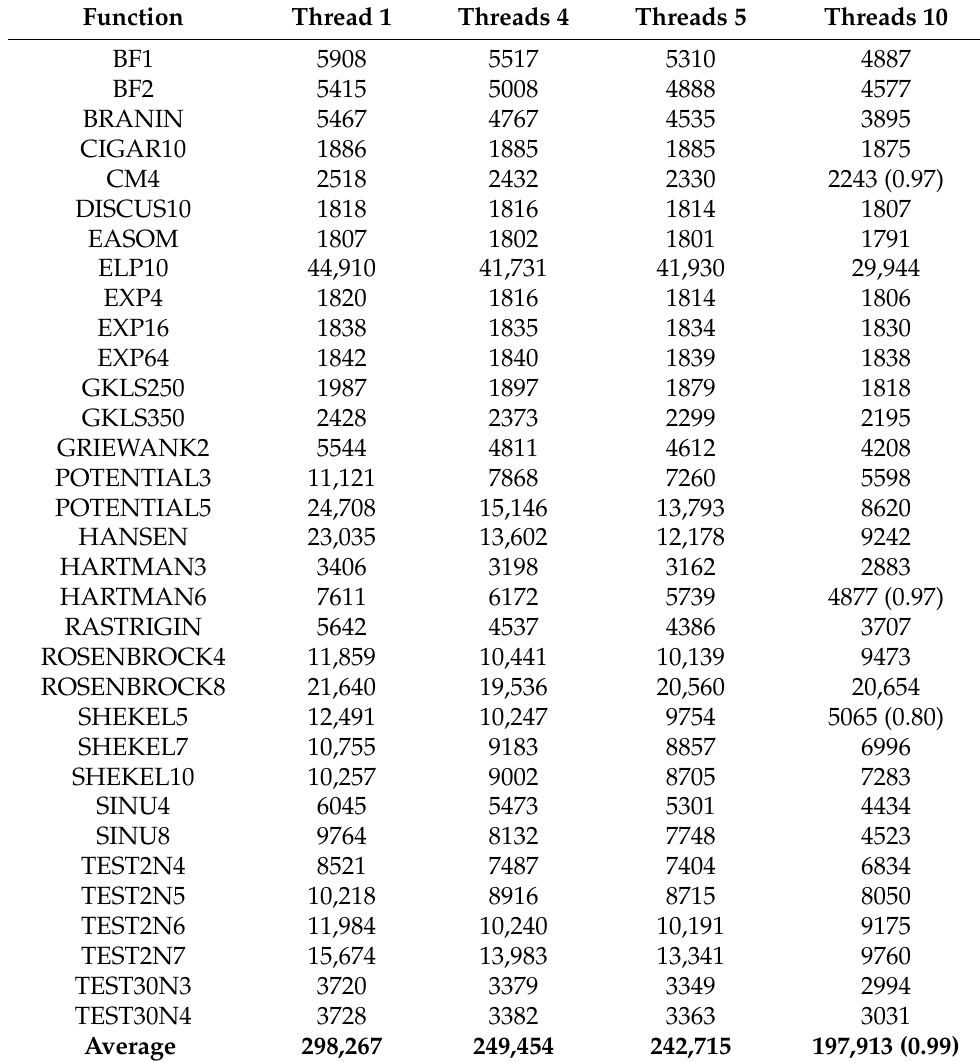
Table 2. Comparison of experimental results with a “1 to 1” propagation scheme. The first column represents the name of the objective function and the remaining columns are the average function calls using 1 to 10 processing threads for the proposed